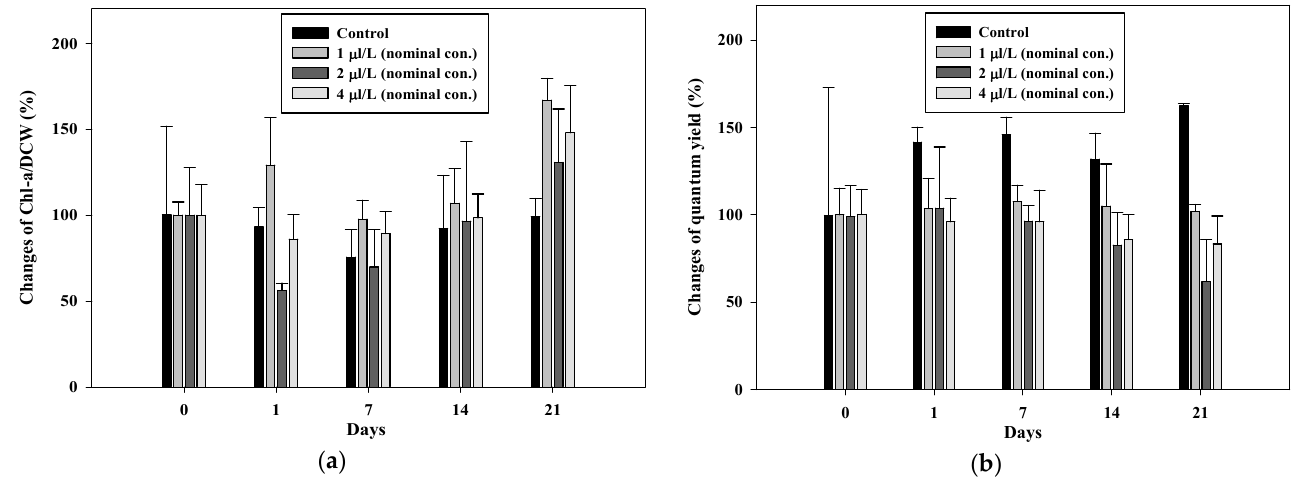
Figure 1. Changes in terms of ( a ) chlorophyll-a/dry cell weight and ( b ) quantum yield.